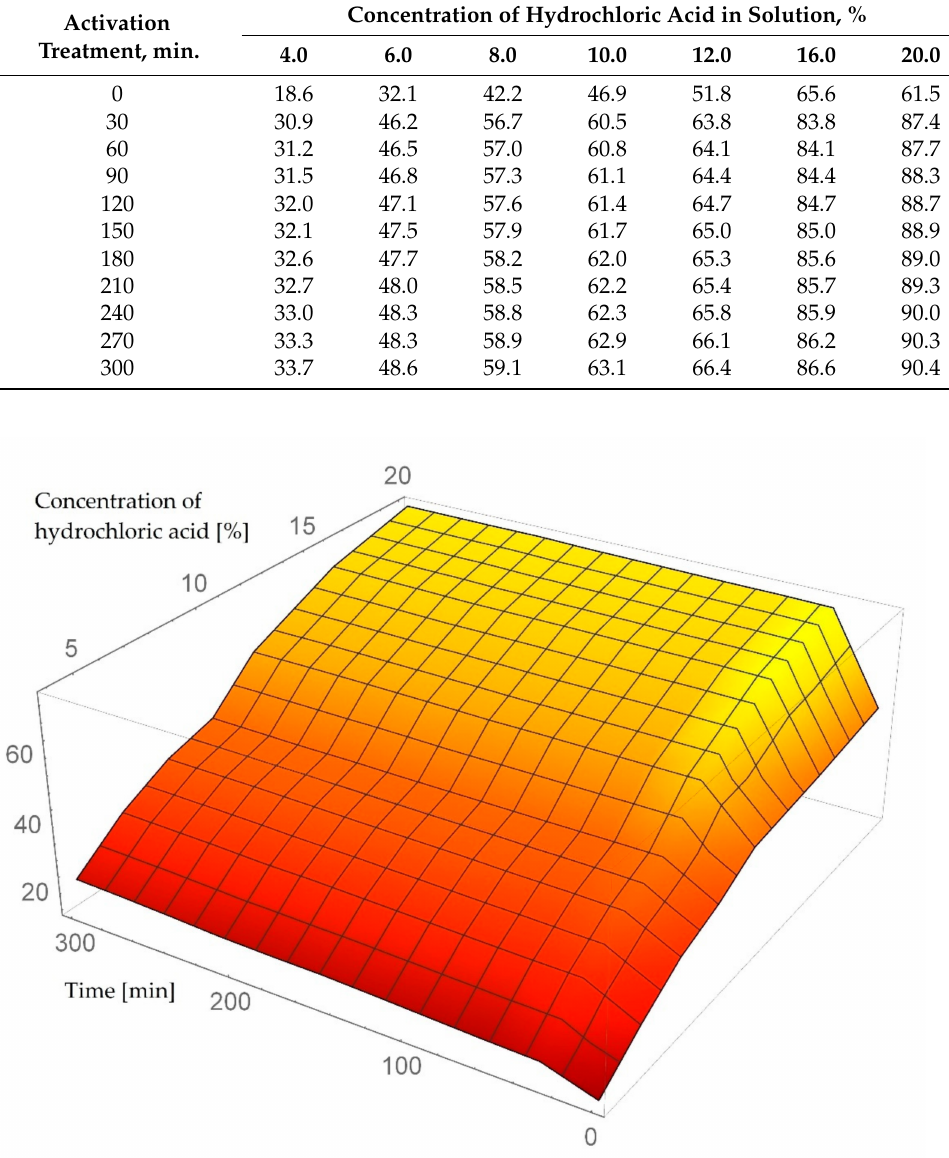
Table 3. Extraction of copper from tailings.